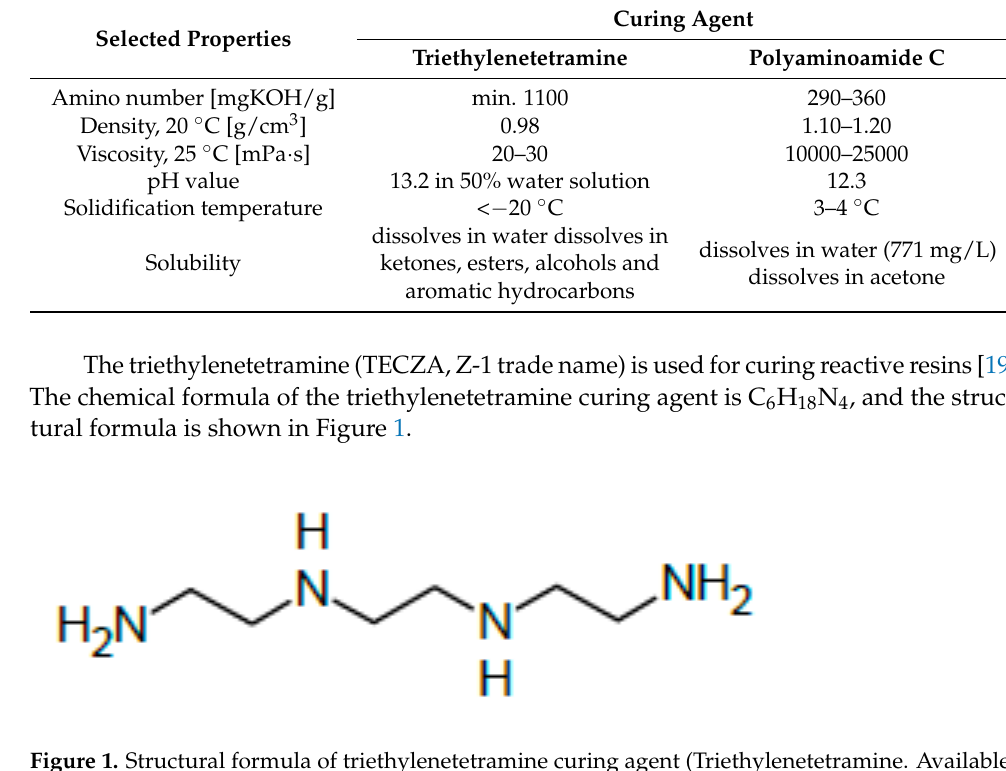
Table 2. Selected properties of curing agents.